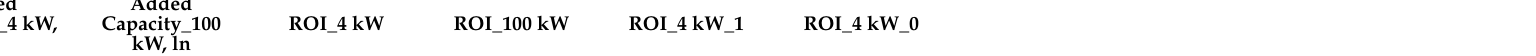
Table A2. Correlation